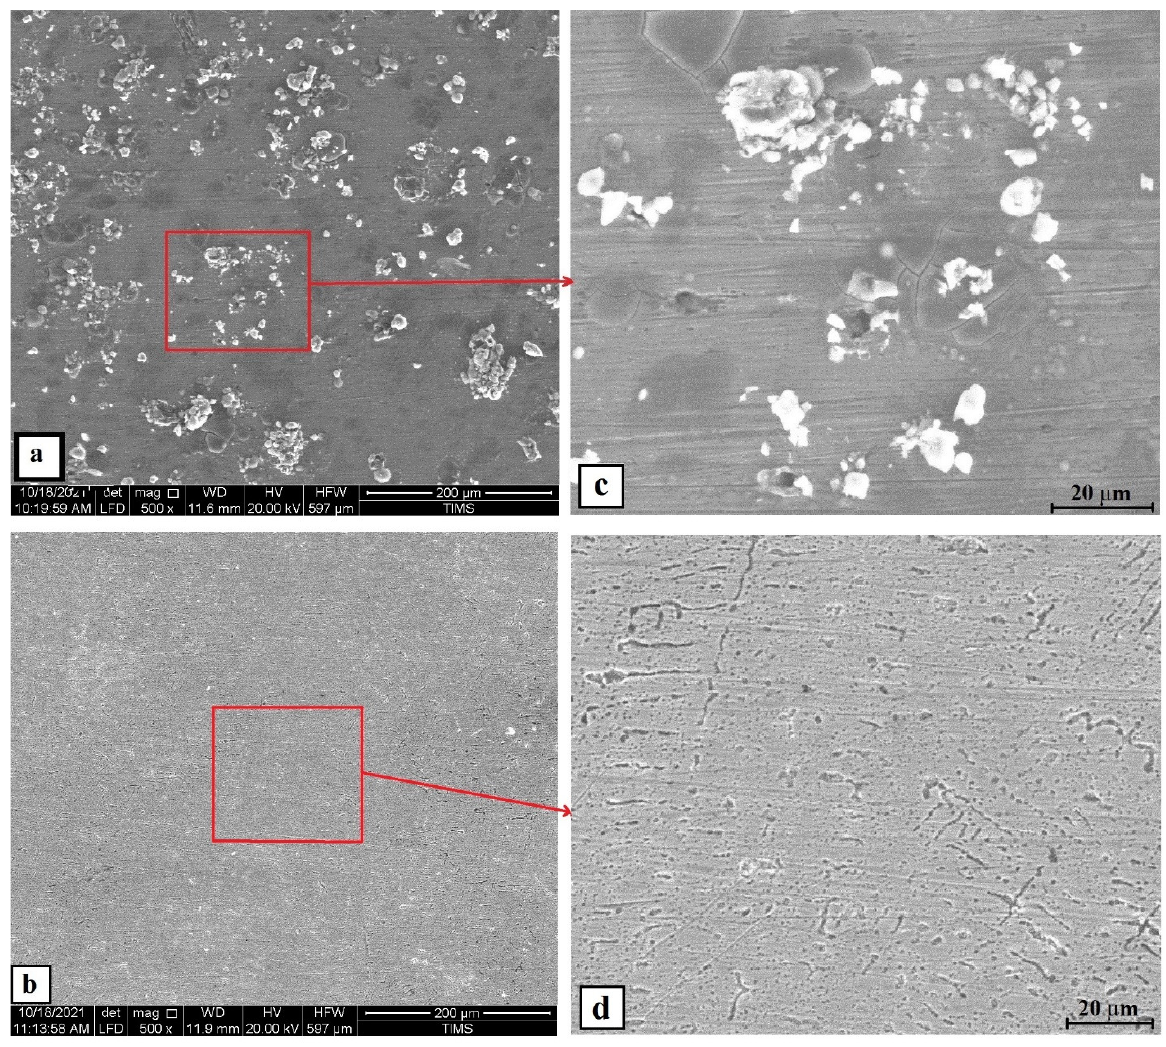
Table 3. EDX analysis of the corrosion products of the surface on cold-rolled (CR) and solution- treated (CR + ST) HEA in 0.6 M NaCl with 0.5 M H 2 SO 4 .